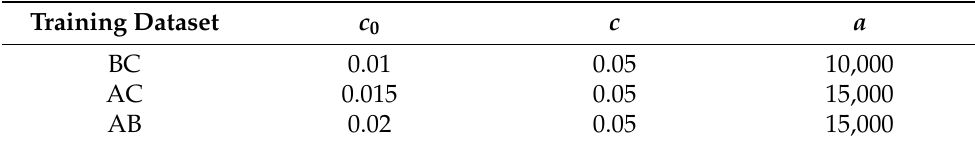
Table 3. Fitted parameters for the exponential model.